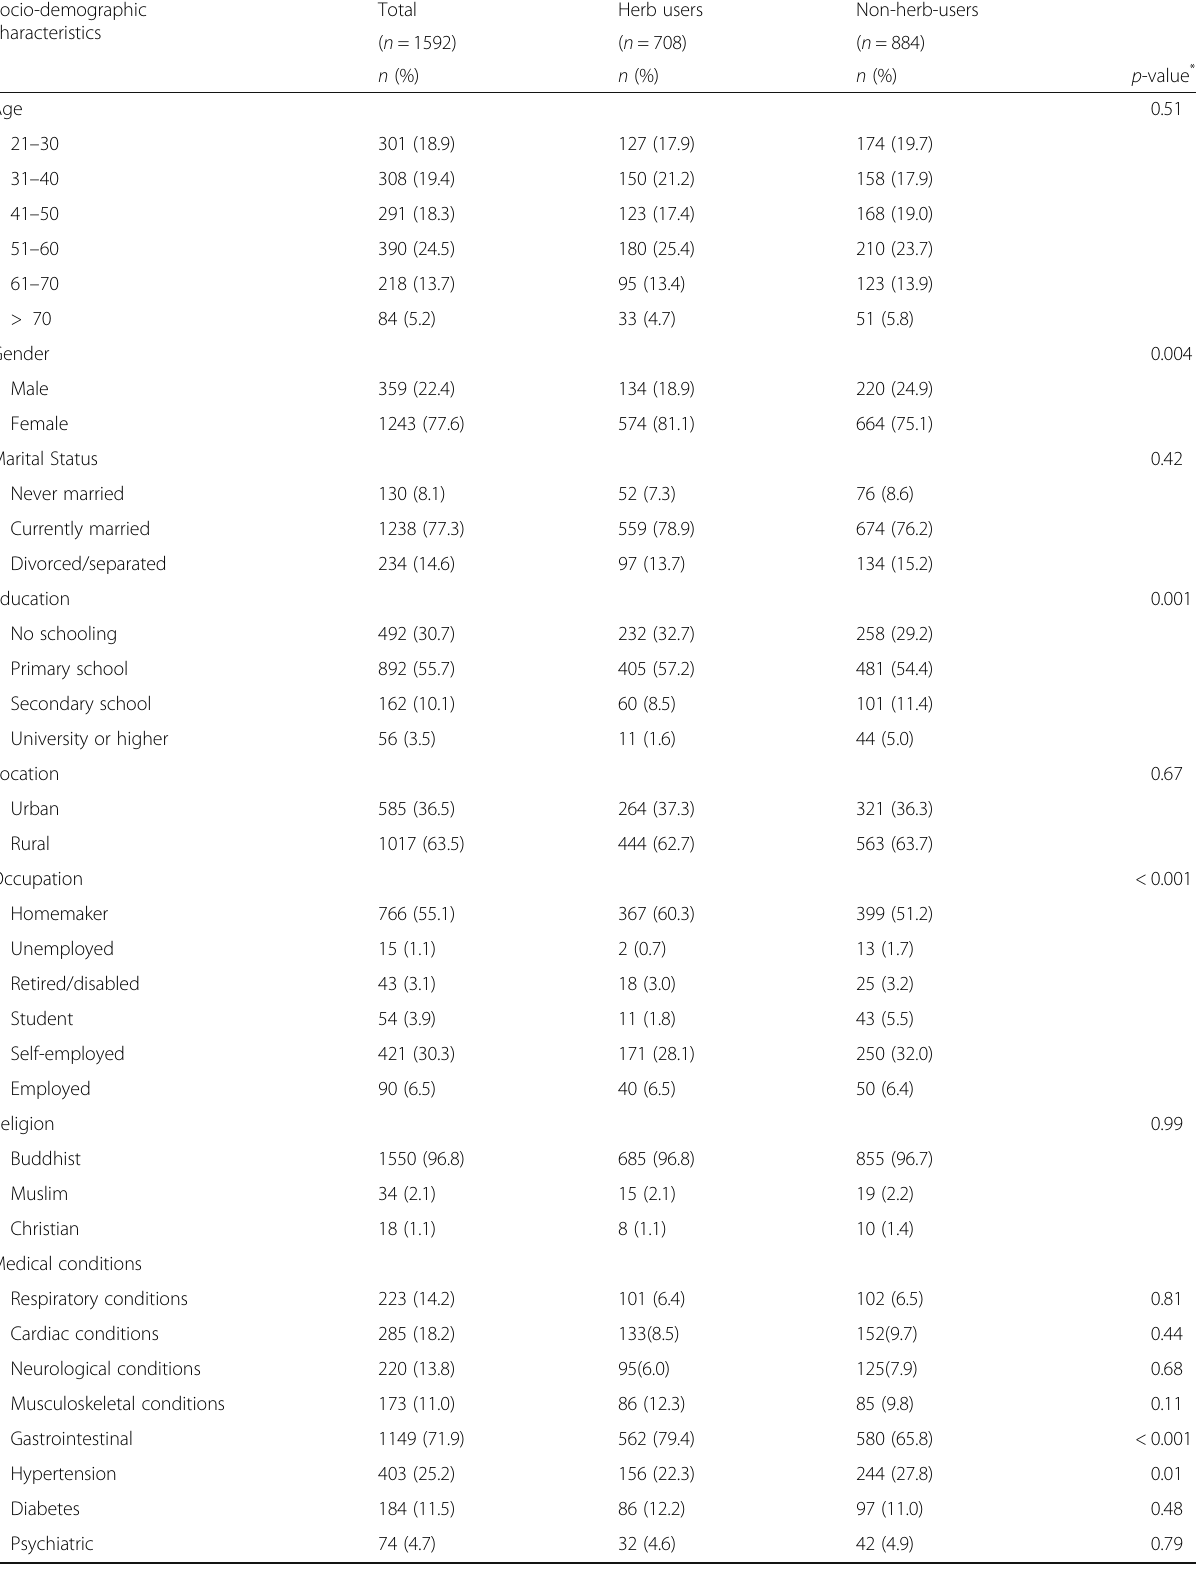
Table 1 Comparison of socio-demographic characteristics among herb users and non-herb-users Socio-demographic